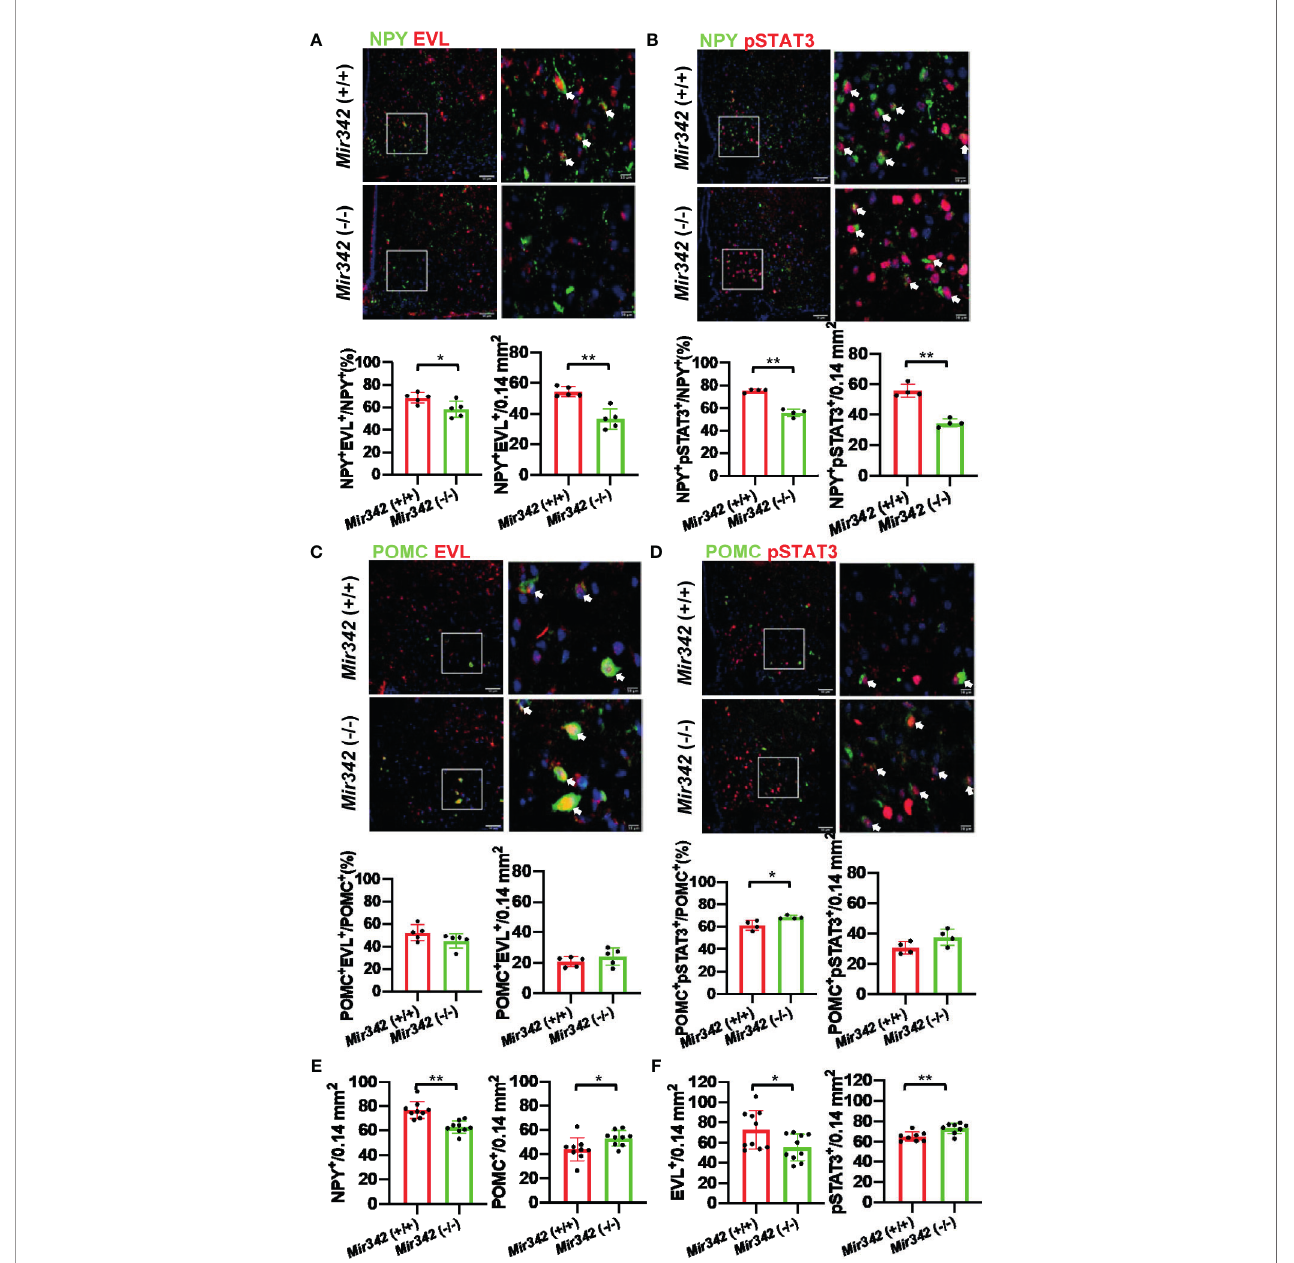
FIGURE 5 | The activation of neuropeptide Y (NPY) and proopiomelanocortin (POMC) neurons by leptin injection. (A) Representative photographs of NPY (Green) and EVL (Red) double staining in arcuate nuclei from Mir342 (+/+) and Mir342 (-/-) mice fed with HFHS chow (n=5 each). The arrows indicate double-positive cells. The percentage and total numbers of NPY + EVL + cells are shown. (B) NPY (Green) and pSTAT3 (Red) double staining in the mice fed with HFHS (n=4) after intraperitoneal injection of leptin (1 mg/kg body weight). The percentage and total numbers of NPY + pSTAT3 + cells are shown. (C) Double staining with POMC (Green) and EVL (Red) in Mir342 (+/+) and Mir342 (-/-) mice fed with HFHS chow (n=5). The percentage and total numbers of POMC + EVL + cells are shown. (D) POMC (Green) and pSTAT3 (Red) double staining in the mice fed with HFHS (n=4) after intraperitoneal injection of leptin (1 mg/kg body weight). The percentage and total numbers of POMC + pSTAT3 + cells are shown. (E) Average cell numbers of NPY + (n=9) and POMC + (n=9) cells detected in hypothalamus of the mice fed with HFHS. (F) Average cell numbers of EVL + (n=10) and pSTAT3 + (n=8) cells detected in hypothalamus of the mice fed with HFHS. Data shown as mean ± SD and analyzed by independent t -test (*p < 0.05; **p <